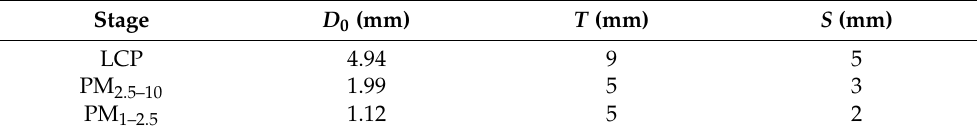
Table 4. Design parameters of cascade impactor.